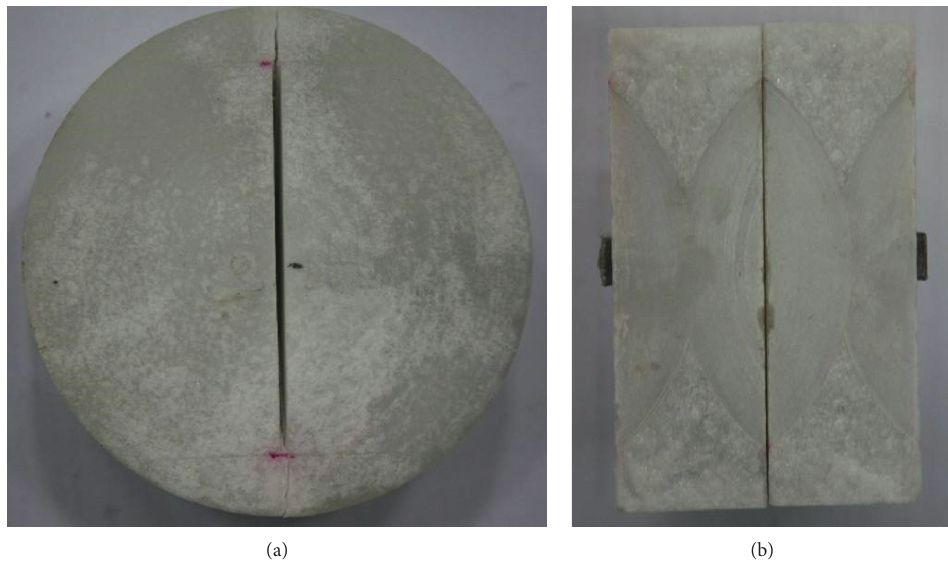
Figure 3: Typical CCNBD sample after the mode I fracture test. Table 1: Fracture toughness and total AE hit of specimens. Specimen